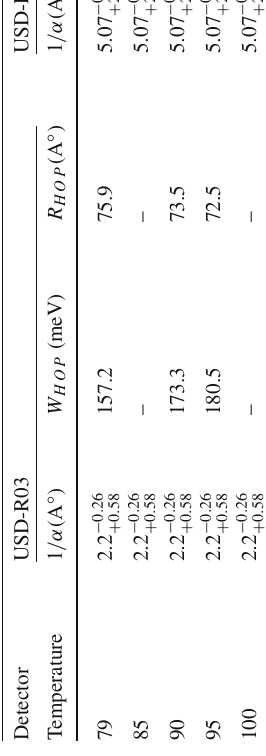
tion length (1 /α ) are lower than the similar work reported previously without hydrogen content. This suggests that the a-Ge created with hydrogen has higher resistance and resis- tivity, suitable for passiviting Ge crystals when making Ge